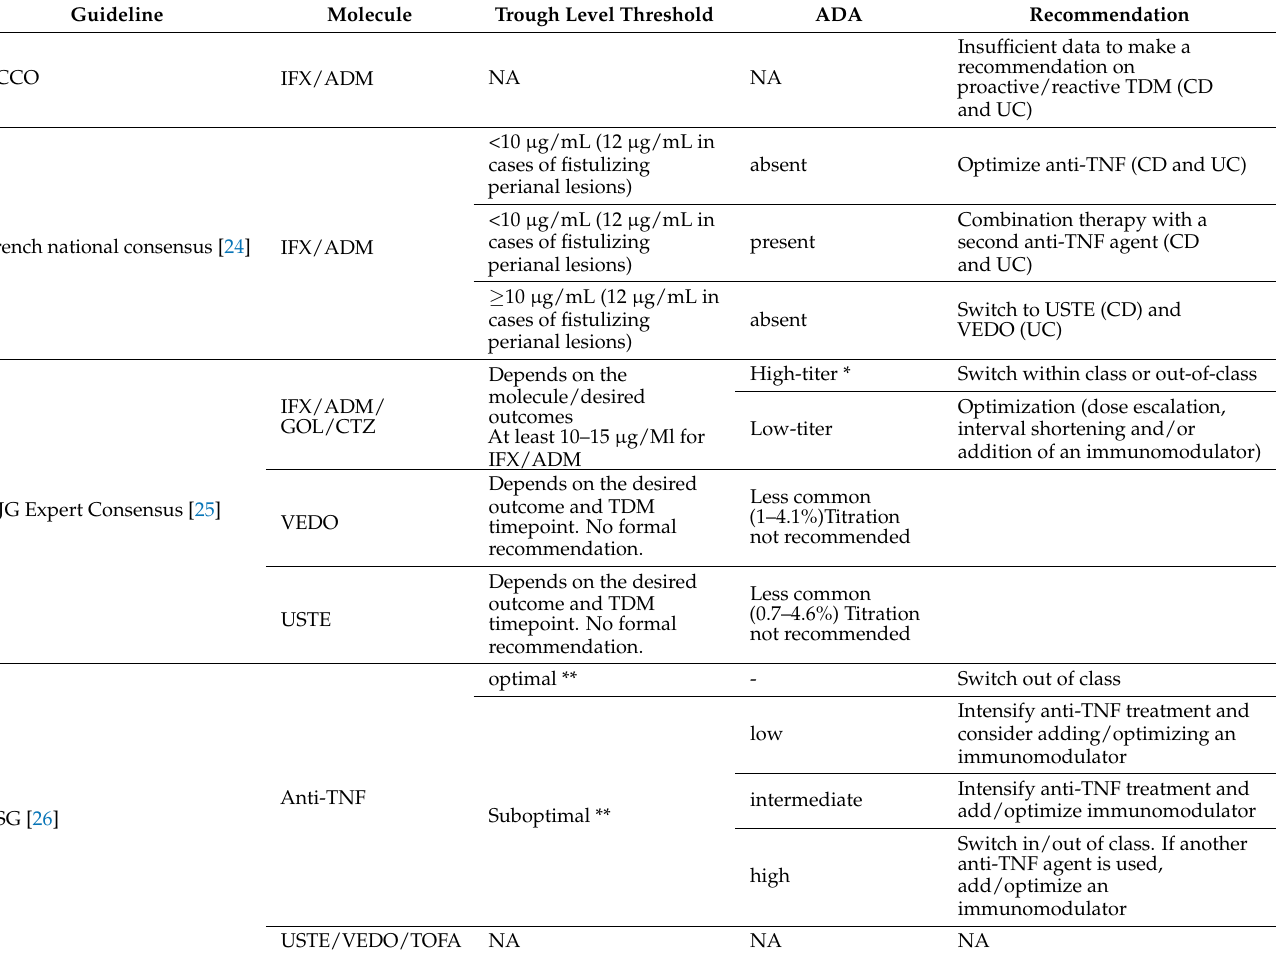
Table 3. Summary of guideline recommendations regarding treatment